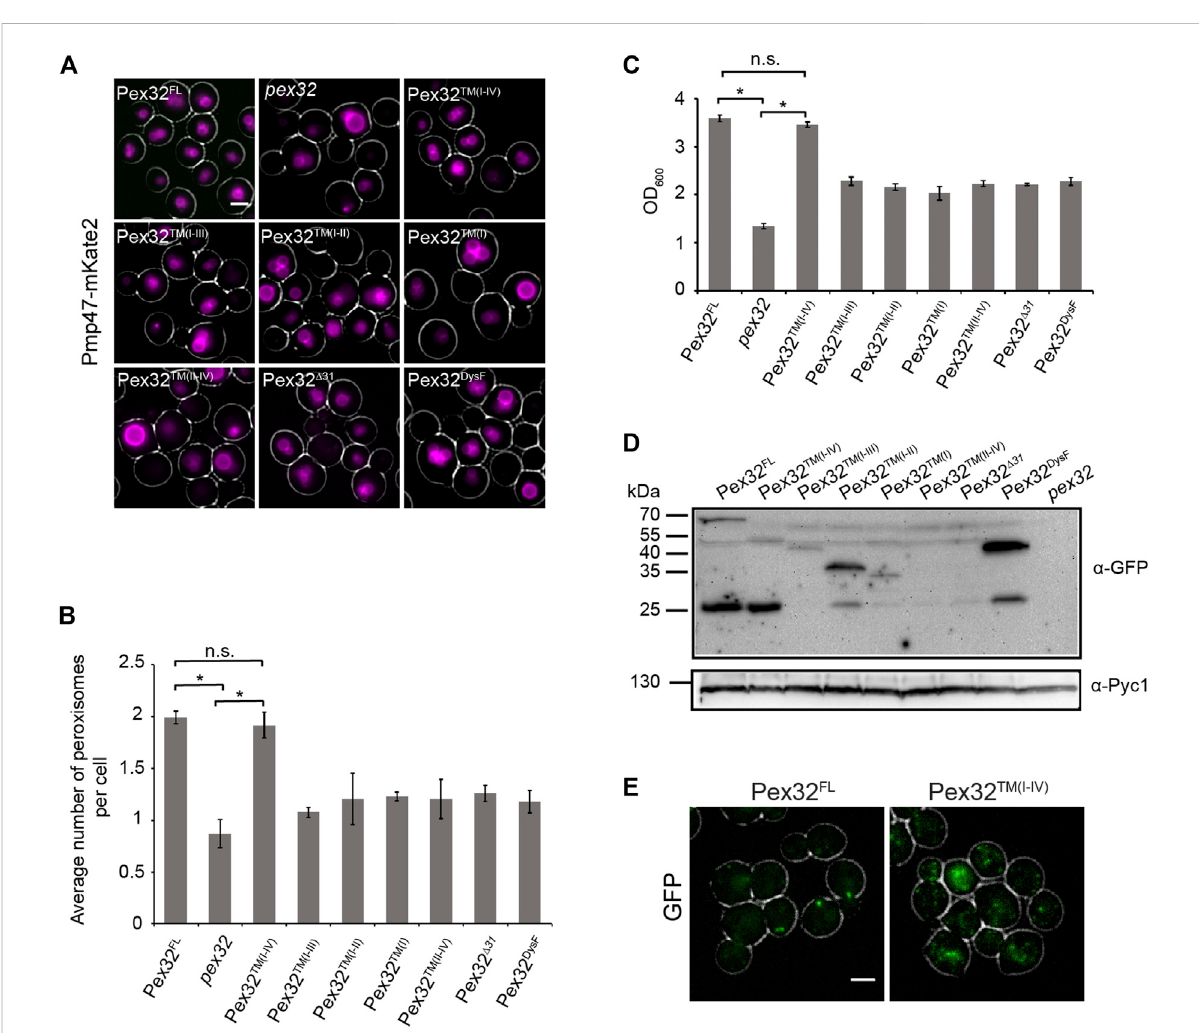
N-terminal domain of Pex32 is important for its function, while the DysF domain is required to accumulate Pex32 at peroxisome-ER contact sites. (A) FM analysis of methanol/glycerol-grown pex32 cells producing Pmp47-mKate2 and indicated Pex32 truncations containing GFP at the C-terminus and produced under the control of PPEX32. Scale bar: 2 μ m. (B) Quanti fi cation of the average number of peroxisomes per cell in the indicated strains. Error bars represent s.d. from three independent experiments ( n = 3 using 200 cells from each experiment). Signi fi cance indications: n. s. = p > 0.05, * = p < 0.01. (C) Optical densities of the indicated strains upon growth for 16 h on methanol/glycerol medium. Signi fi cance indications: n. s. = p > 0.05, * = p < 0.01. Error bars represent s.d. from three independent experiments. (D) Western blot analysis of the indicated strains. Cells were grown in a methanol/glycerol medium for 16 h. Blots were decorated with anti-GFP or anti-Pyc1 antibodies. Pyc1 was usedasaloadingcontrol. (E) FManalysisofglucose-grownWTcellsproducingPex32-GFP(left)orpex32cellsproducingPex32TM(I-IV)(right).Scale bar: 2 μ